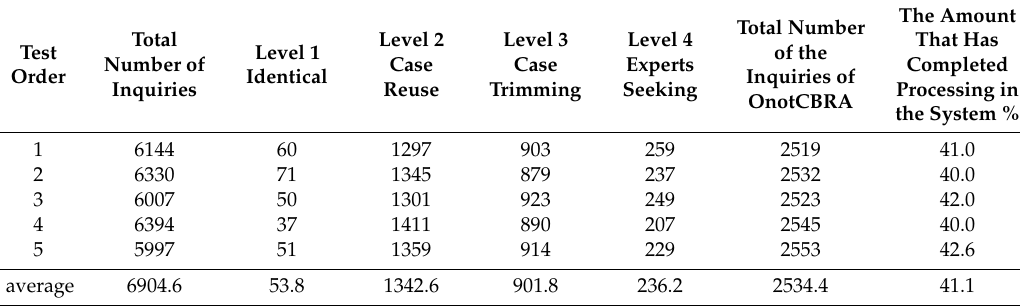
Table 8. Analysis results of learning e ff